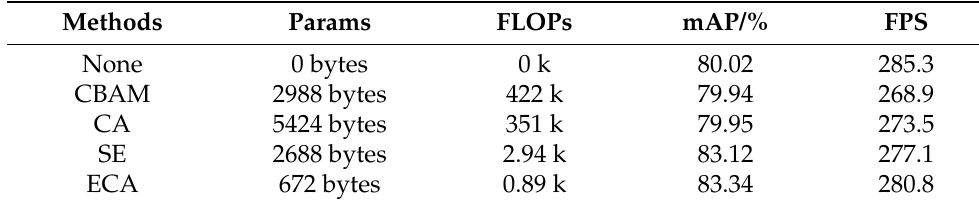
Table 4. Comparison of different attention methods.